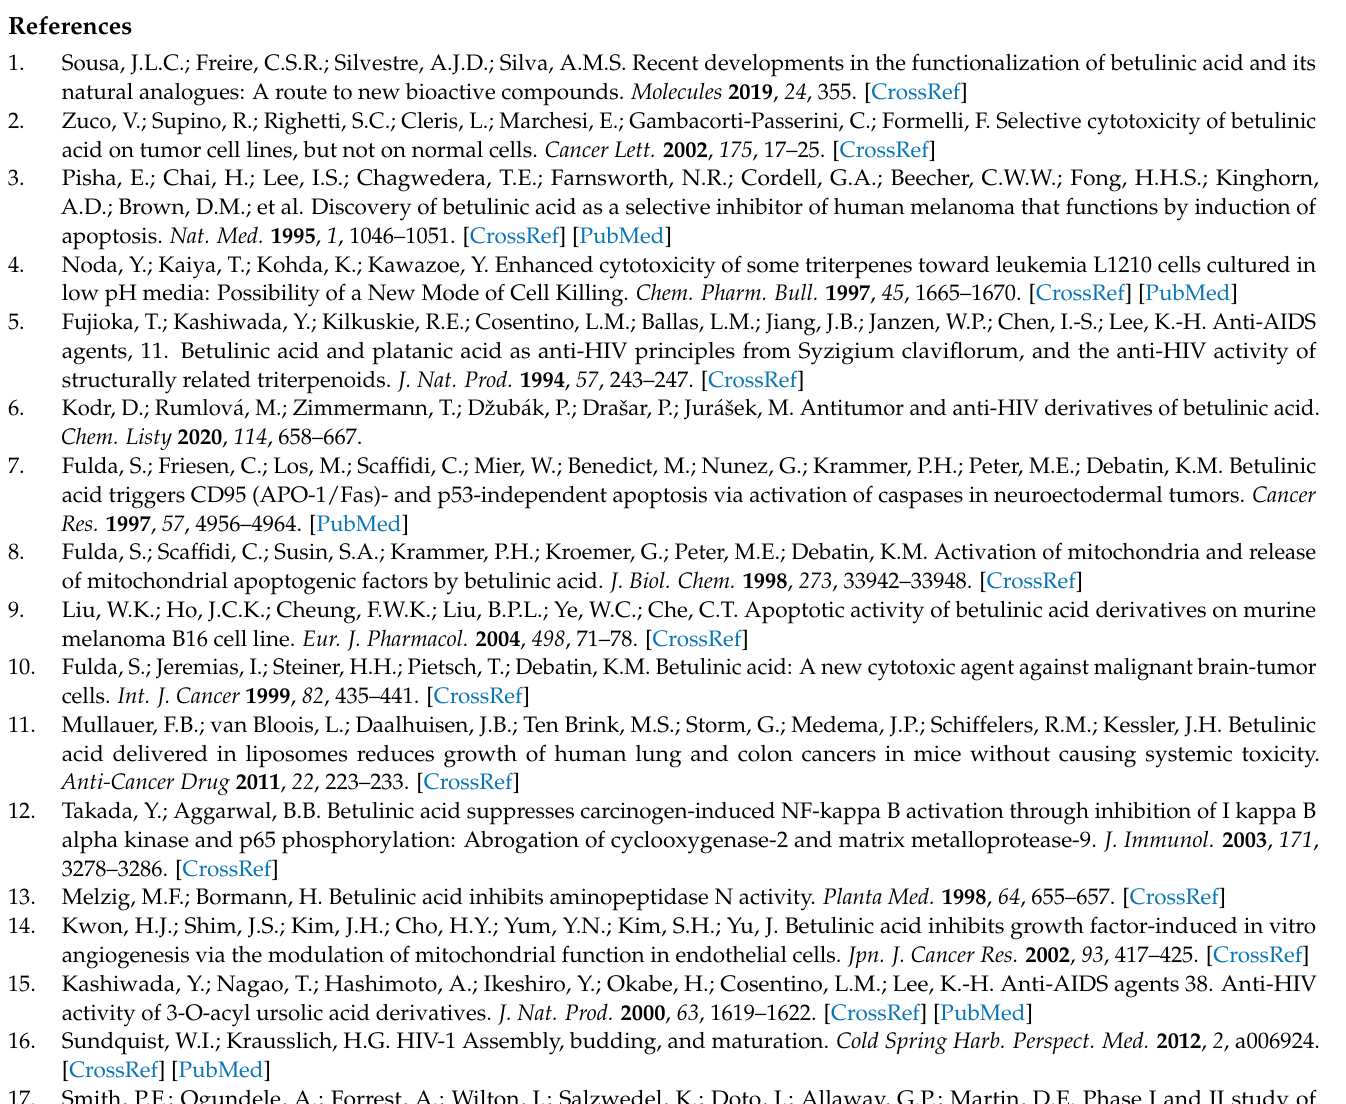
microscopy. Figure S57: Effect of selected tested compounds on CA-SP1 processing of HIV-1 Gag polyprotein (a duplicate of western blot showed in Figure 5. in the